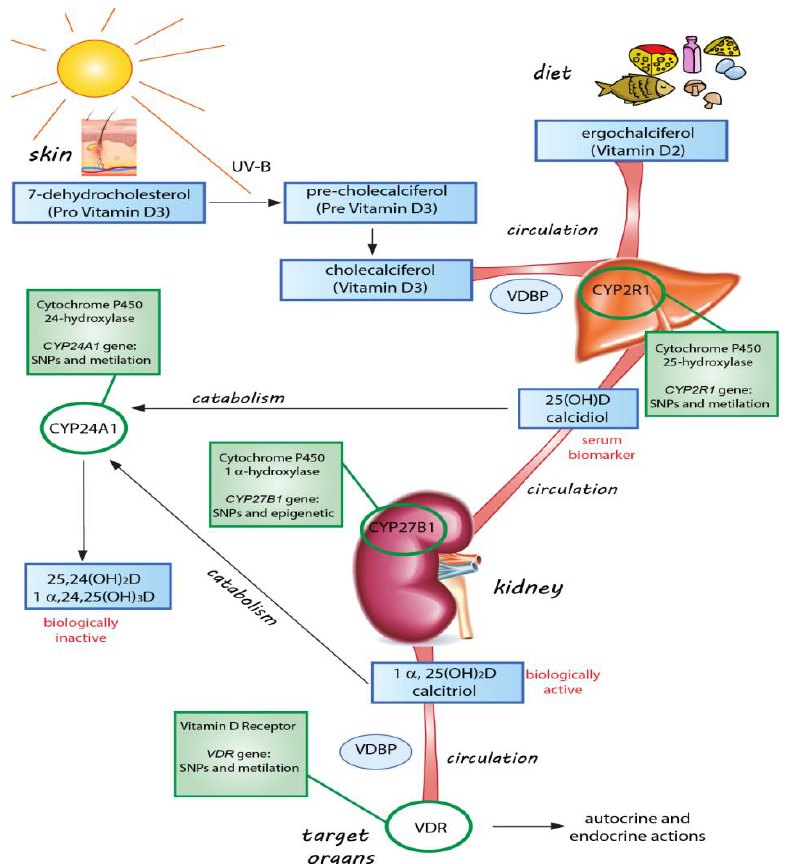
Figure 1. Absorption and metabolism of Vitamin D in human body. Skin or diet: 7-dehydrocholesterol (provitamin D3) is converted into pre-cholecalciferol (previtamin D3) by UV light and then modified into cholecalciferol (vitamin D3). The dietary source of vitamin D is ergocalciferol (vitamin D2). Circulation: Cholecalciferol and ergocalciferol are prohormones transported into the blood by vitamin-D-binding protein (VDBP), but to become active they must be hydroxylated. Liver: Vitamin D2 and D3 are hydroxylated by the cytochrome P450 mixed-function oxidases encoded by CYP2R1 (see green box), generating the 25 hydroxy vitamin D [25(OH)D], or calcidiol. Kidney: 25(OH)D is further hydroxylated by 1 α -hydroxylase encoding by CYP27B1 (see green box) and generating 1,25 dihydroxy vitamin D (1,25(OH) 2 D or calcitriol), which is the biologically active molecule. Catabolic pathway: CYP24A1 gene coding for a 24-hydroxylase enzyme (see green box), which can inactivate both 25(OH)D and 1,25(OH)D via hydroxylation. Target organs: 1,25(OH) 2 D is bound by VDBP and it reaches the target organs where the Vitamin D receptor (VDR) mediates its absorption. VDR, encoded by the VDR gene (see green box), is crucial in the vitamin D endocrine and autocrine systems.